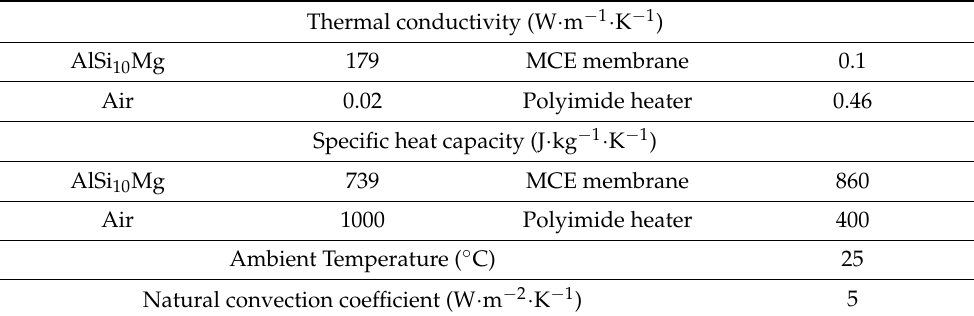
Table 1. Major simulated parameters in COMSOL.